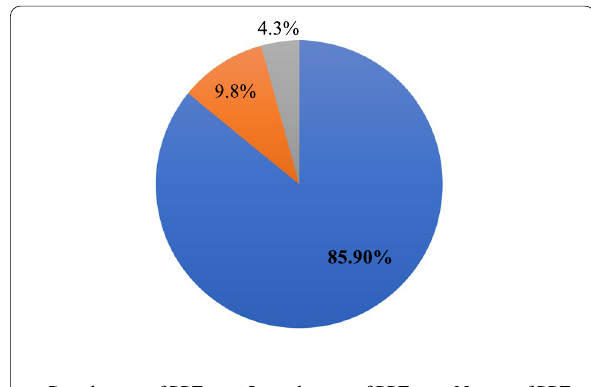
Fig. 1 Distribution among industrial workers according to the use of personal protective equipment